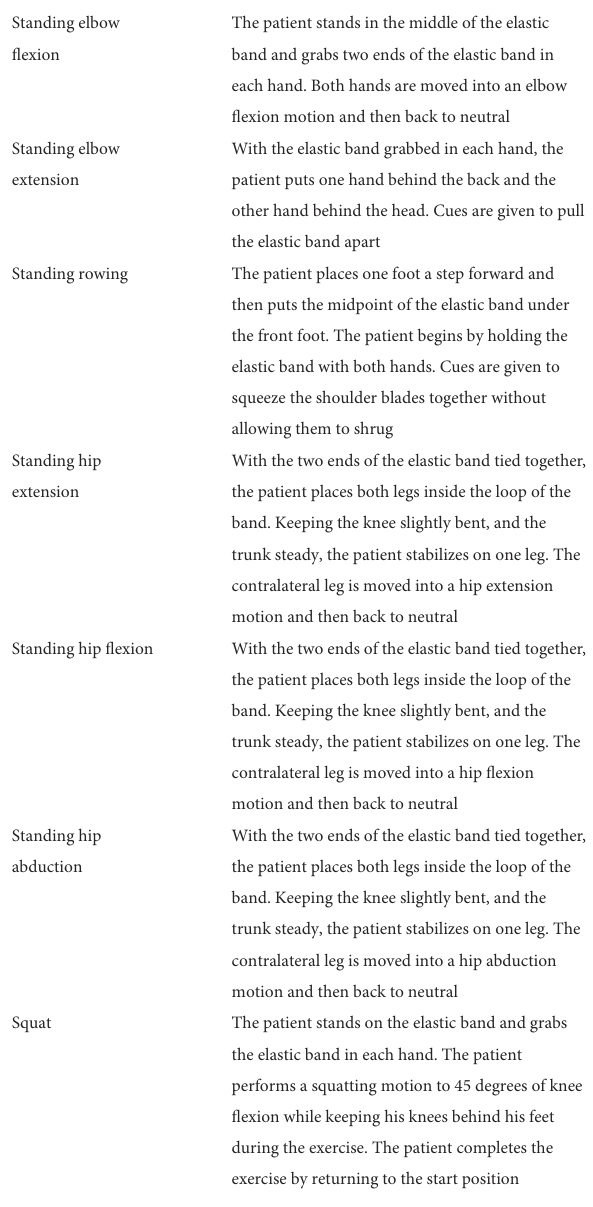
TABLE 2 Movements in elastic band